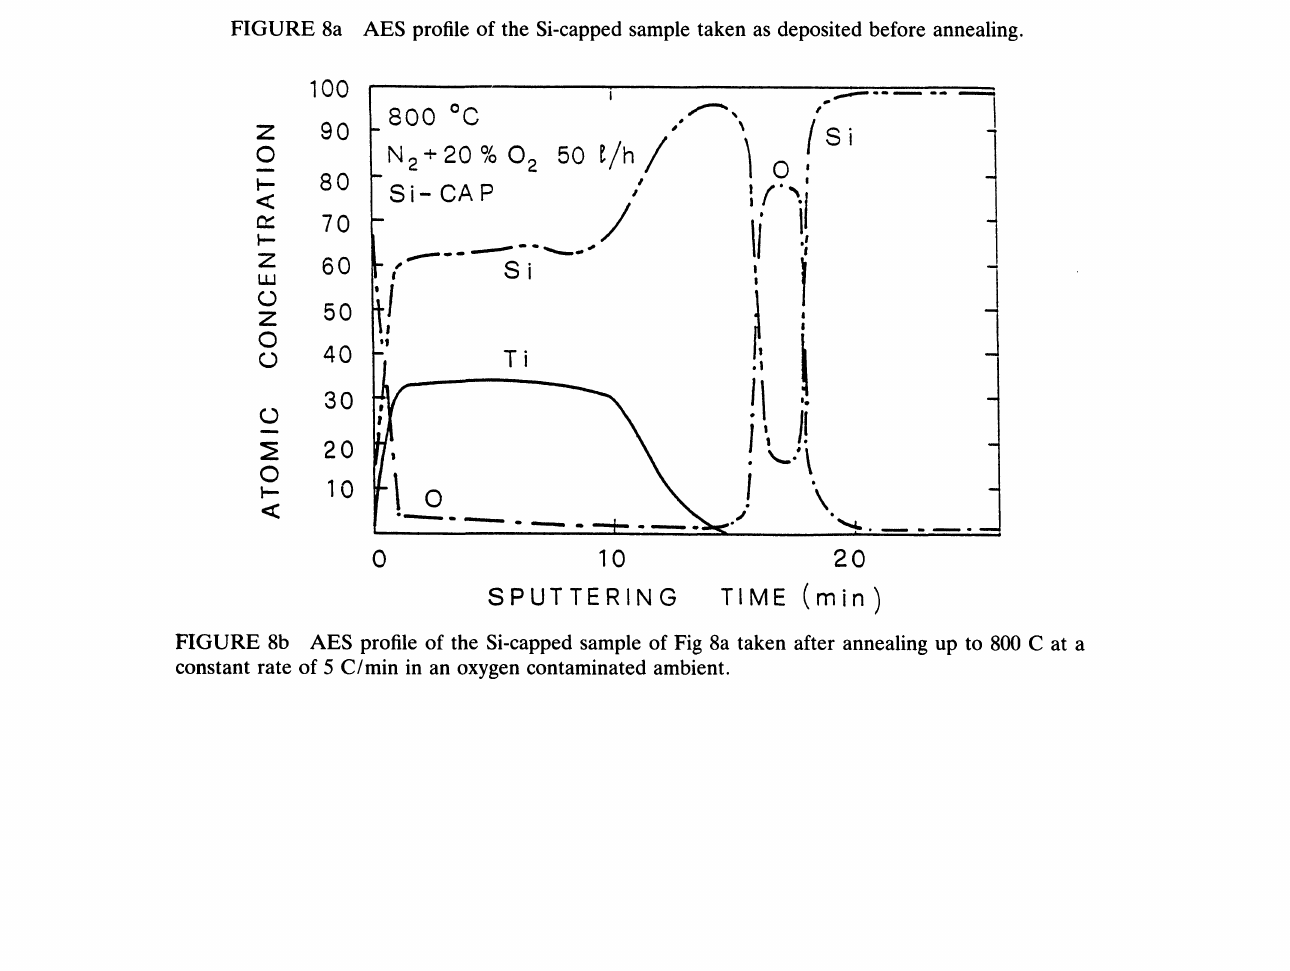
FIGURE 8a AES profile of the Si-capped sample taken as deposited before annealing.